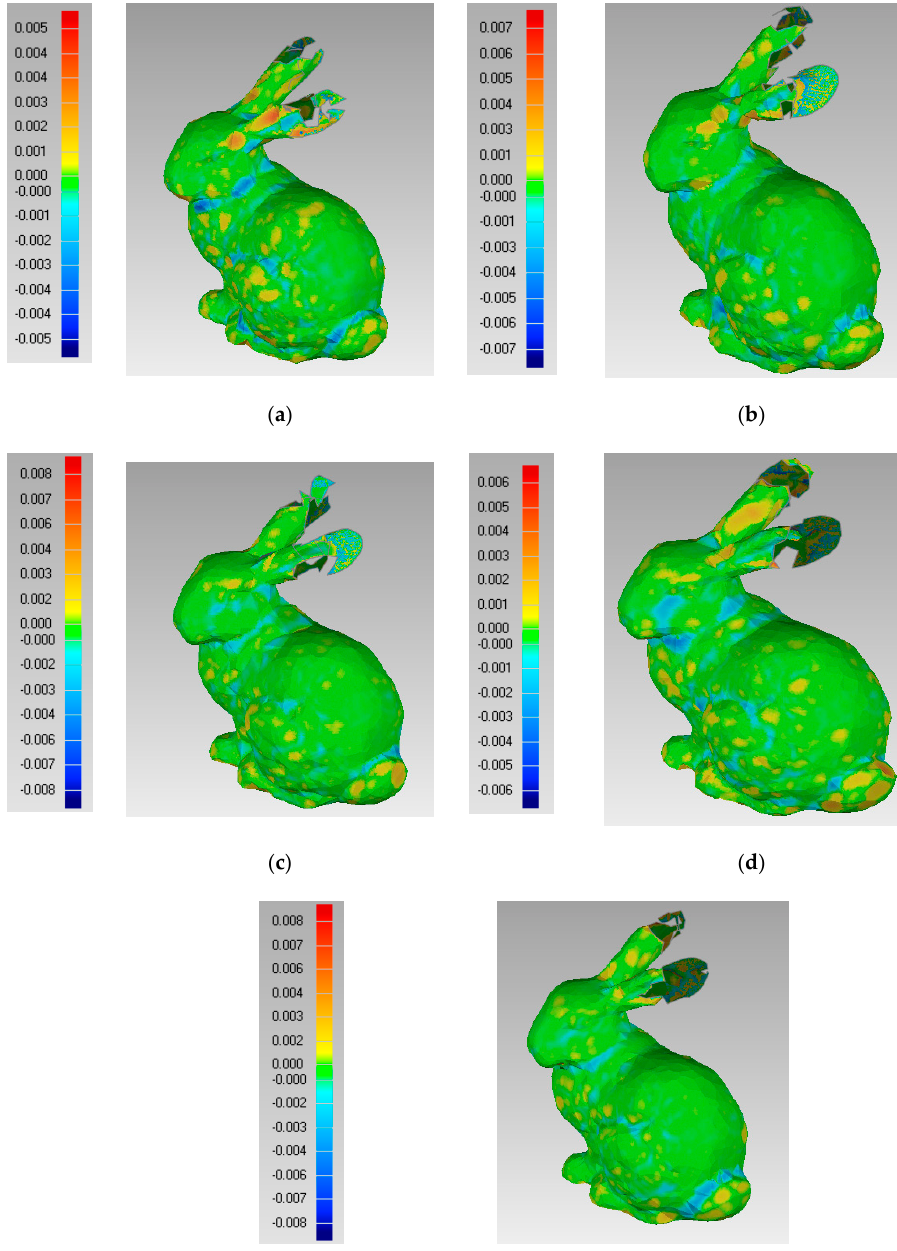
Figure 9. Comparison of the simplified surface and original surface: ( a ) the parameters of FPPS are k = 10 and σ = 1000; ( b ) the parameters of FPPS are k = 25 and σ = 400; ( c ) the parameters of FPPS are k = 50 and σ = 200; ( d ) the parameters of FPPS are k = 80 and σ = 130; ( e ) the parameters of FPPS are k = 100 and σ =